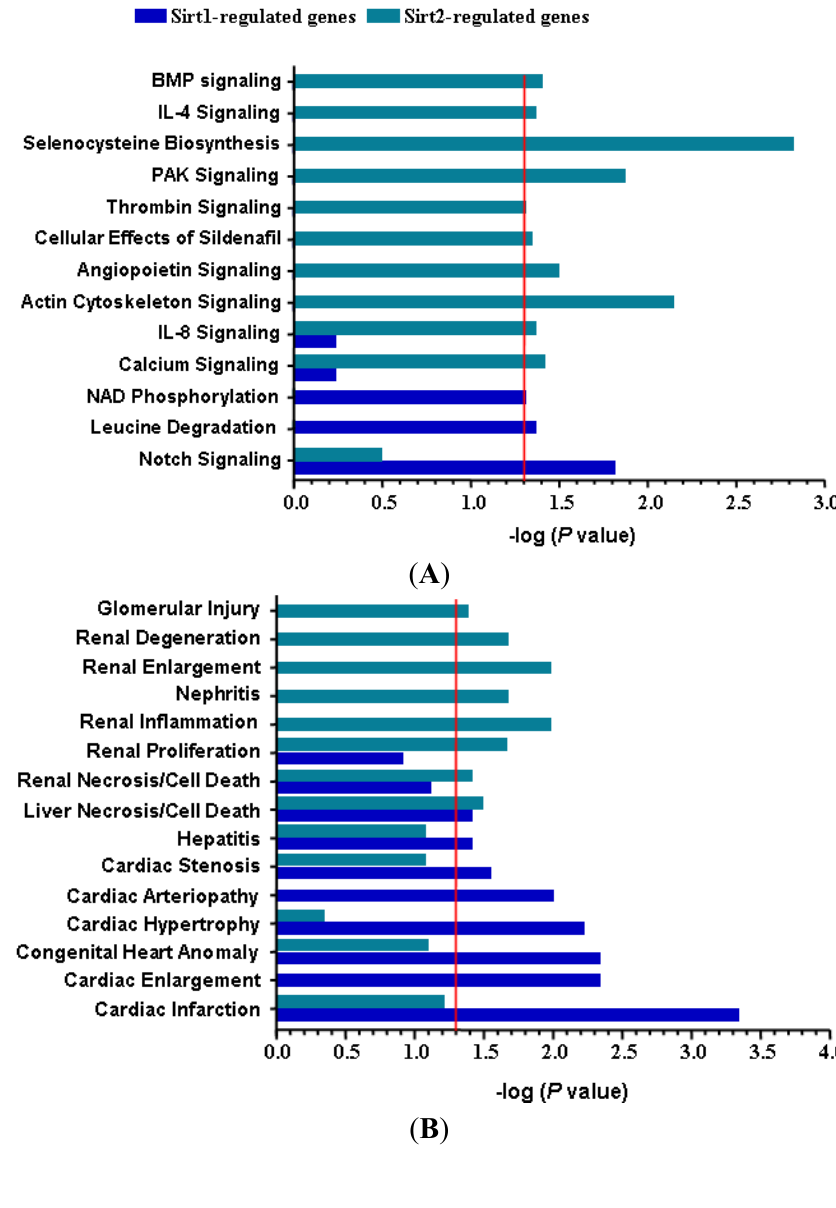
Figure 4. Comparison of the potential categories of ( A ) intracellular pathways and ( B ) biological mechanisms related to toxicity responses that were significantly over-represented by Sirt1- or Sirt2-regulated genes respectively in stressed endothelial cells. The red line indicates the threshold of statistical significance. Functional gene enrichment analysis was performed with IPA